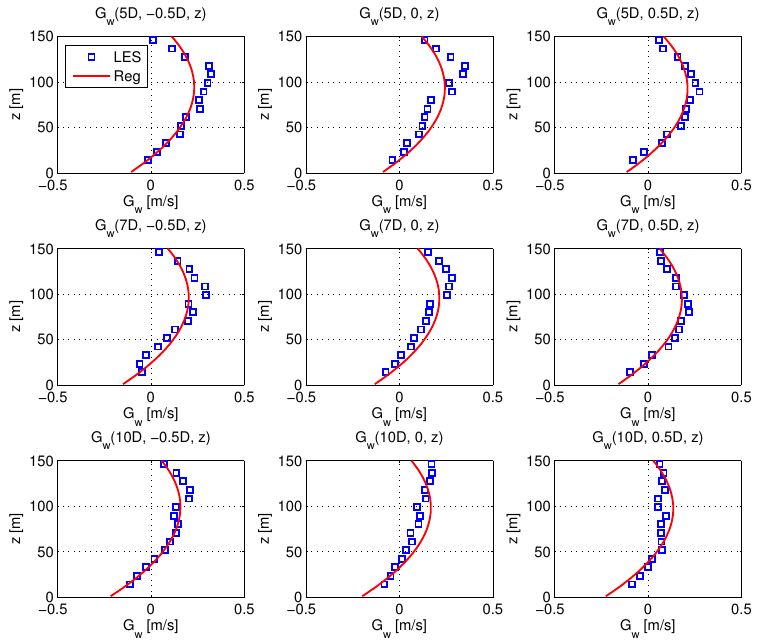
Figure 23. Spatial variation of G w : LES versus regression-based